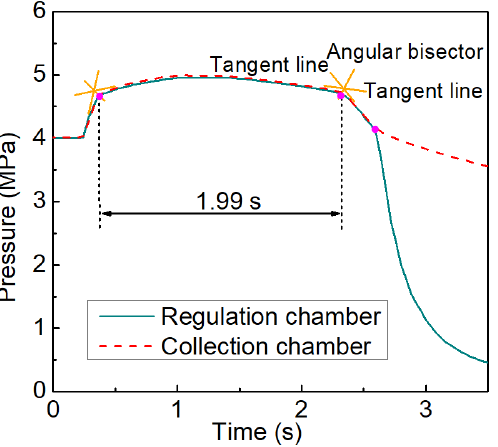
Figure 3. Experimental pressure-time curves of propellant combustion.